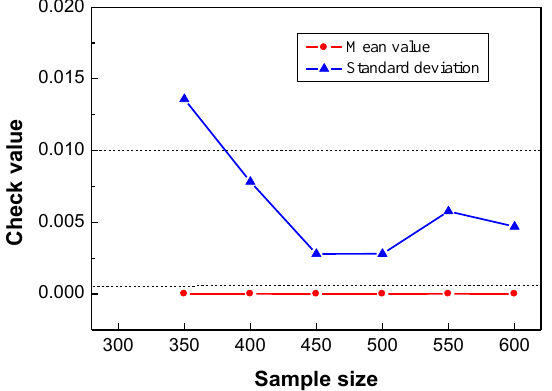
Figure 6. Sampling size test of first frequency every 50 samples.